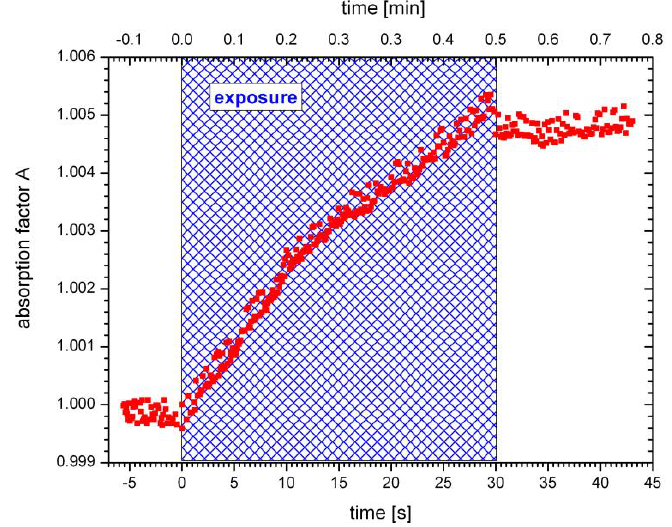
Figure 5. Measured absorption for the undoped SU-8 during single beam exposure. The absorption factor increases during exposure. Exposure duration was 30 s (shaded area). factor increases during exposure. Exposure duration was 30 s (shaded